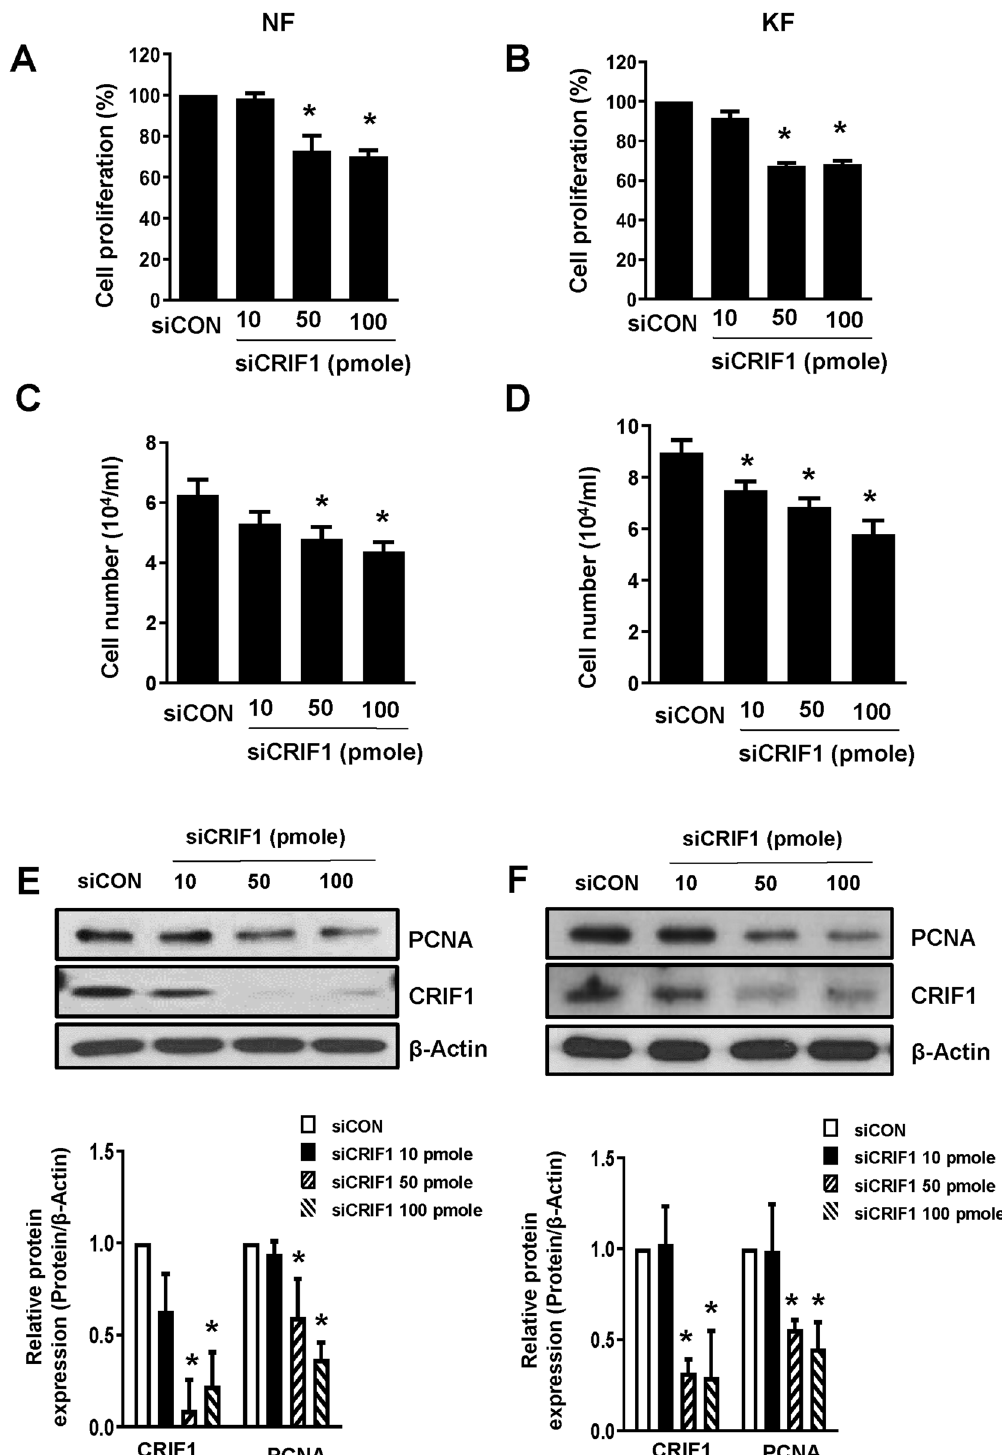
Figure 3. CR6-interacting factor 1 (CRIF1) downregulation leads to decreased cell proliferation in normal fibroblasts (NFs) and keloid fibroblasts (KFs). NFs were transfected with CRIF1 small interfering RNA (siRNA) in a dose-dependent manner for 48 h. ( A ) After incubation, cells were treated with CCK-8 solution, with cell proliferation measured based on absorbance at 450 nm. ( C ) After incubation, cells were harvested and ADAM-MC kit was used for cell counting. ( E ) PCNA protein levels were measured by Western blot; β-actin was used as the loading control. PCNA density was calculated using ImageJ software. Full-length blots are presented in Supplementary Fig. S3. KFs were transfected with CRIF1 small interfering RNA (siRNA) in a dose-dependent manner for 48 h. ( B ) After incubation, cells were treated with CCK-8 solution, with cell proliferation measured based on absorbance at 450 nm. ( D ) After incubation, cells were harvested and ADAM-MC kit was used for cell counting. ( F ) PCNA protein levels were measured by western blot; β-actin was used as the loading control. PCNA density was calculated using ImageJ software. Full-length blots are presented in Supplementary Fig. S4. All data are presented as means ± SD of three independent experiments. * P < 0.05 compared to